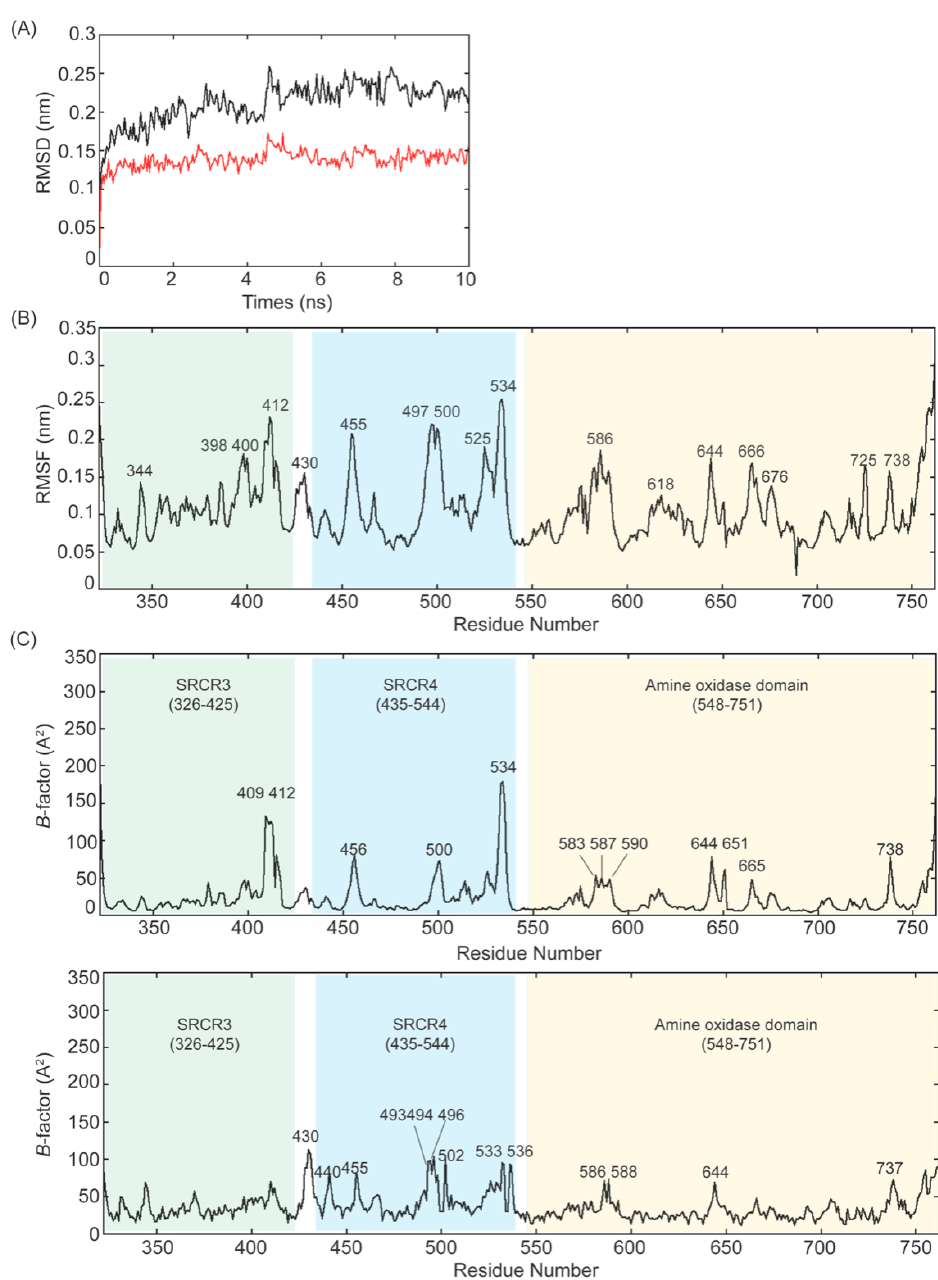
Figure 7. MD − simulation of the 2HP − inhibited Δ 1 − 2SRCR − LOXL2. ( A ) Plot of RMSD values of the C α atoms of Δ 1 − 2SRCR − LOXL2 backbone (in black) and the amine oxidase domain of LOXL2 (in red) during 10 ns of simulation. The MD − simulation for the former shows a gradual increase in the RMSD value with fluctuations, stabilizing at an average of 0.23 nm, while the latter quickly ( ≤ 1 ns) reaches a plateau of RMSD, stabilizing at an average of 0.14 nm. ( B ) Plot of RMSF values of the C α atoms of Δ 1 − 2SRCR − LOXL2 for 10 ns of simulation where fluctuations are ≤ 0.253 nm. ( C ) Top panel: C α B − factor/residue of the MD − simulated Δ 1 − 2SRCR − LOXL2 plotted against amino acid residue numbers. All peaks except the last peak at 755 ( α 3 helix) are loops. Bottom panel: C α B − factor/resi- dues of precursor LOXL2 plotted against amino acid residue numbers.